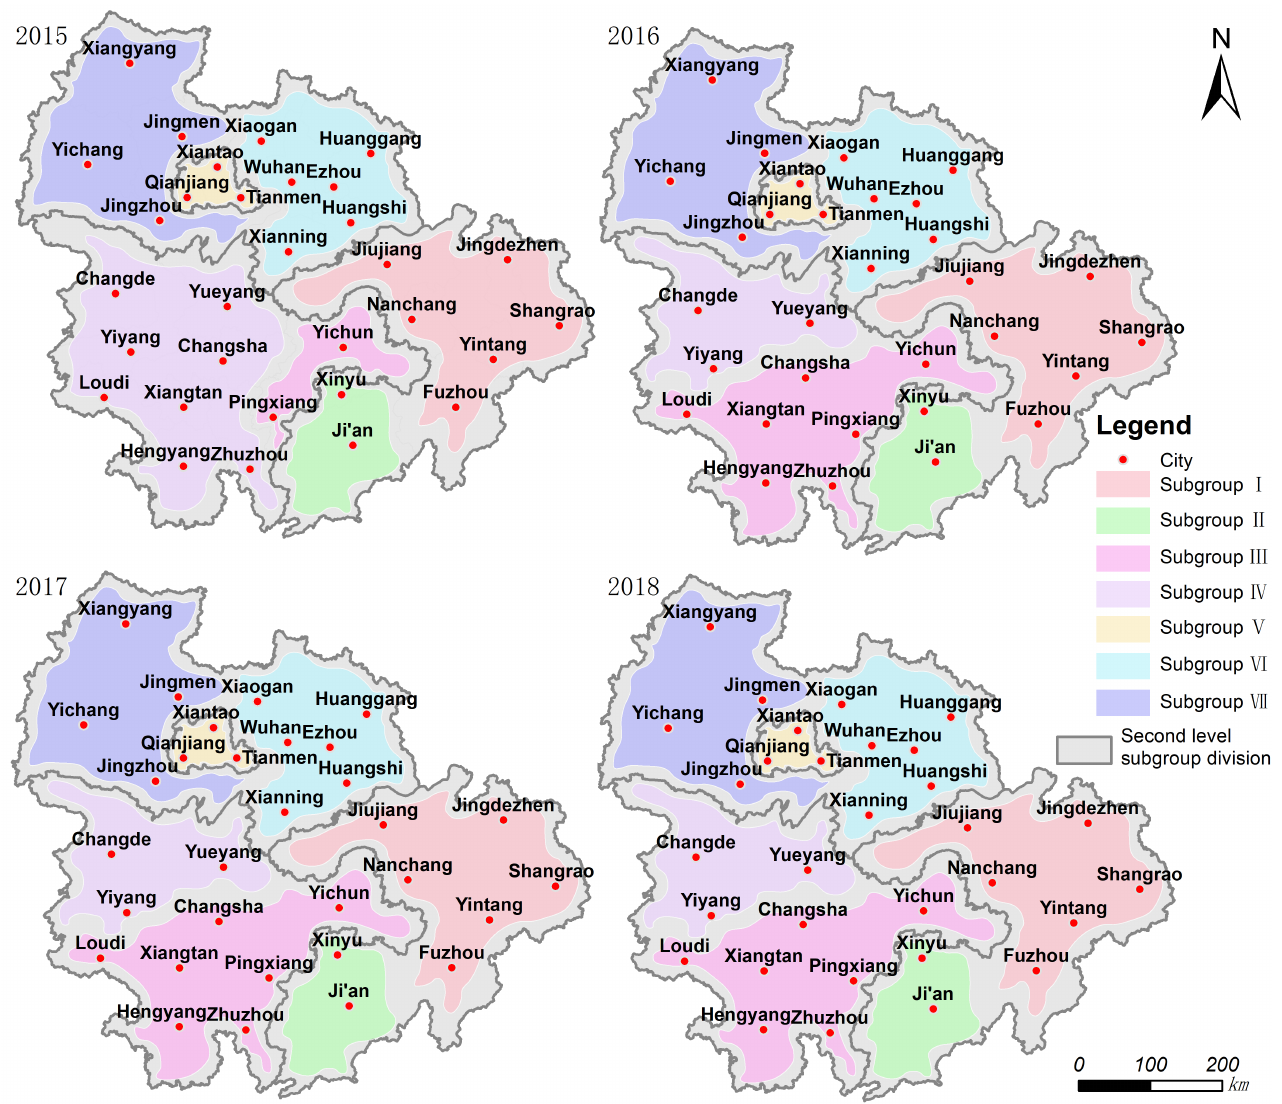
Figure 6 . Evolution of cohesive subgroups in the innovation network of the UAMRYR. Figure 6. Evolution of cohesive subgroups in the innovation network of the